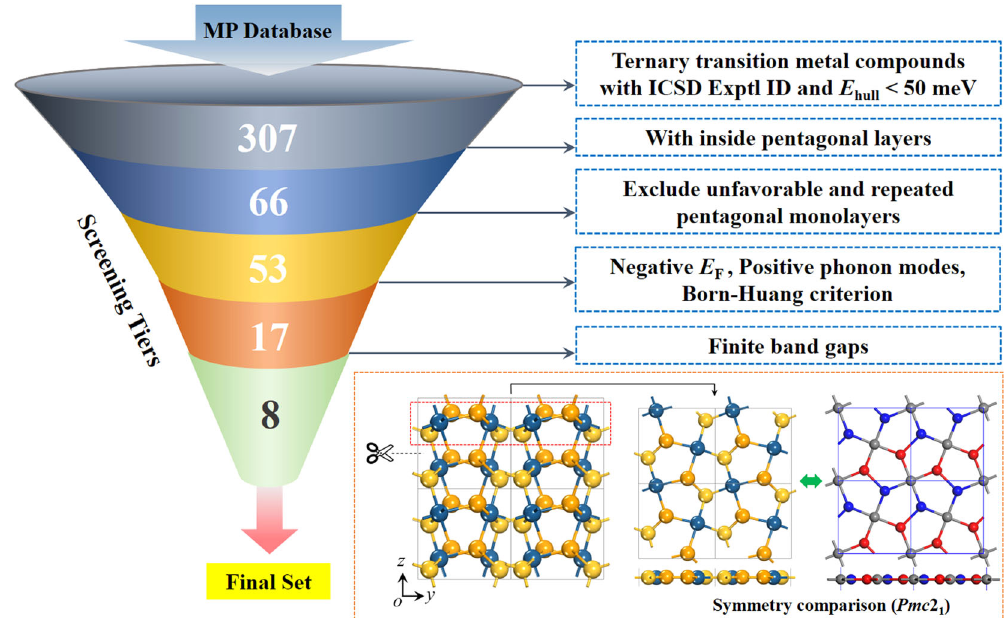
Fig. 2 High-throughput screening funnel for the ternary pentagonal semiconducting monolayers. The scheme of searching for such sheet from a bulk compound composed of pentagonal layers is presented in the orange dashed